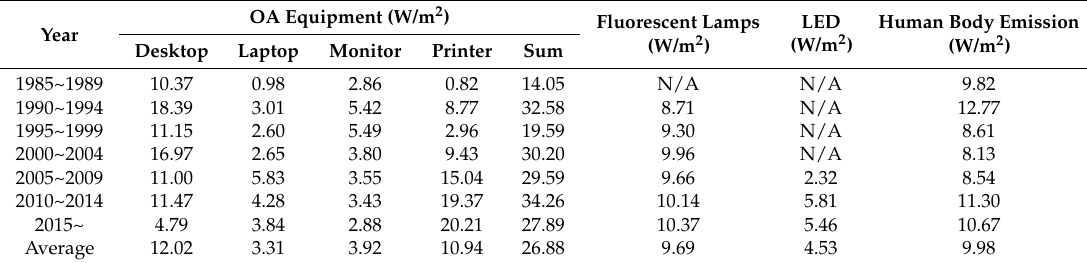
Table 8. Calculation result for internal heat load per unit area by